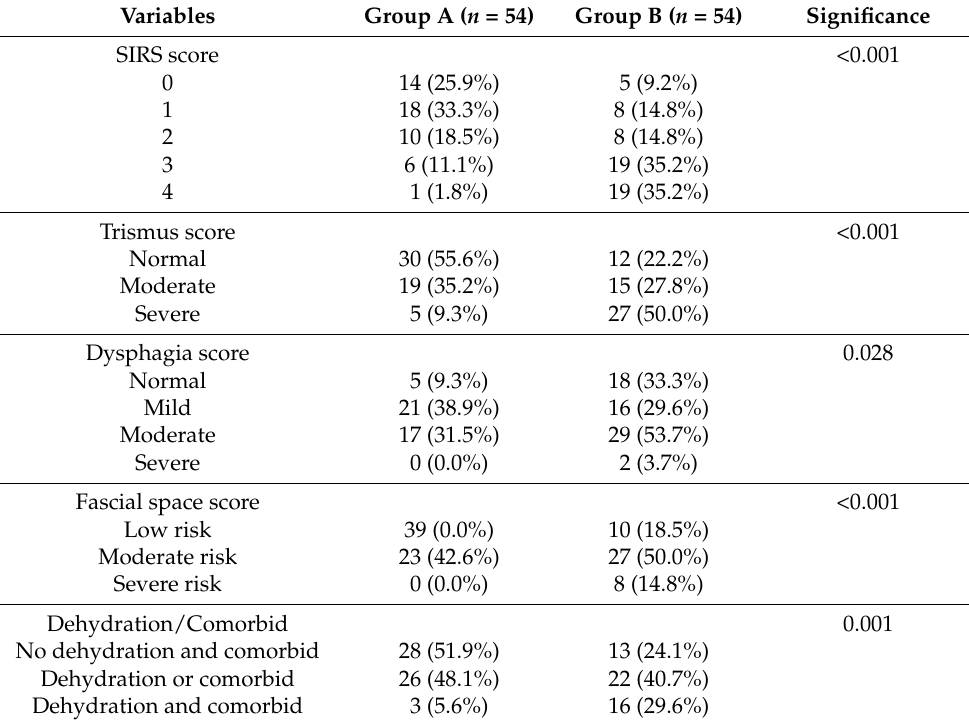
Table 4. SS score differences among patients with odontogenic infections.